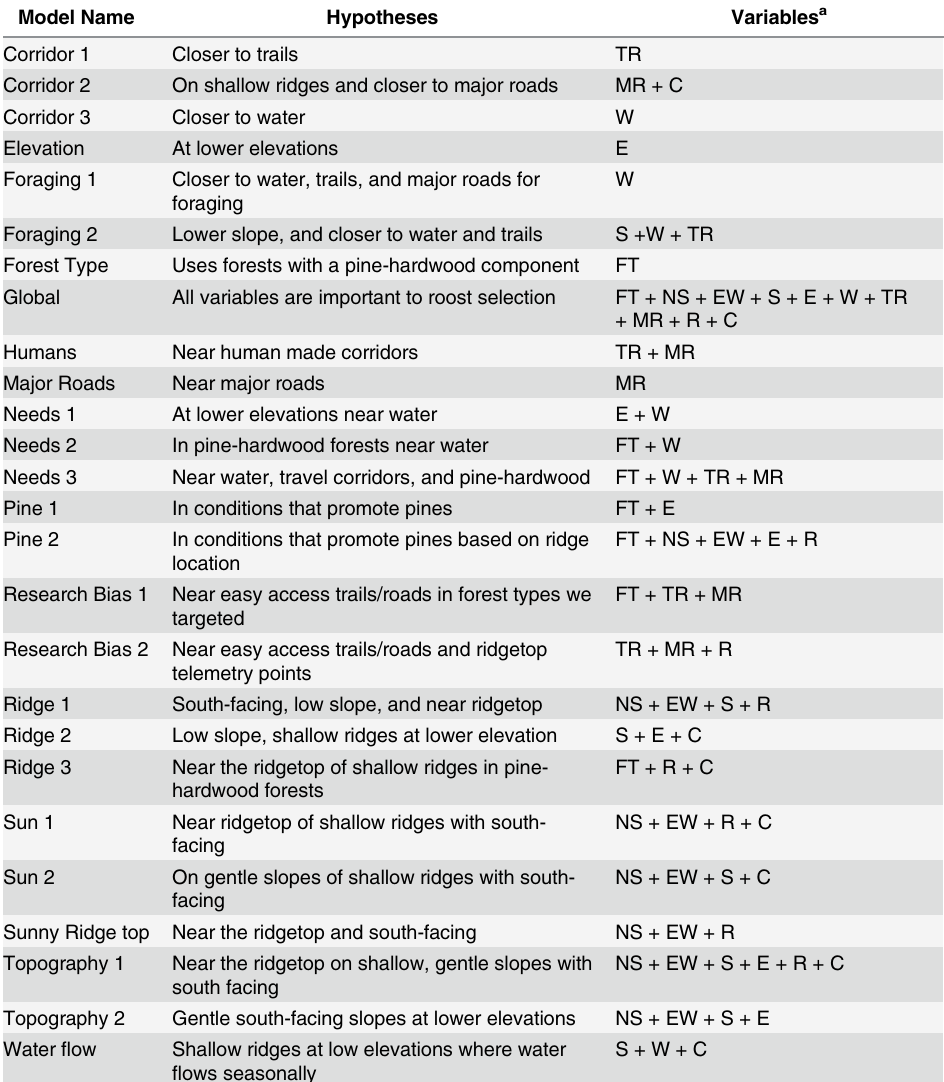
Table 1. Candidate